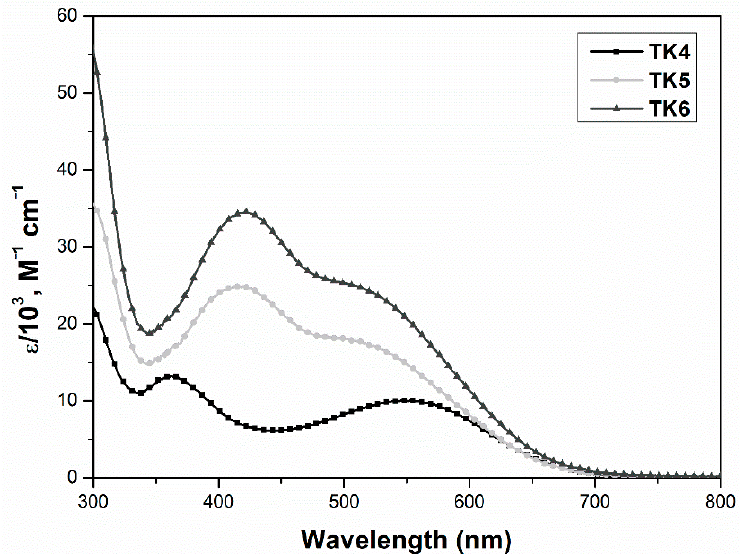
Figure 10. Absorption spectra of TK4 , TK5 and TK6 in CH 2 Cl 2 . Reprinted (adapted) with permission from ref. [104]. Copyright {2016} “Elsevier.”